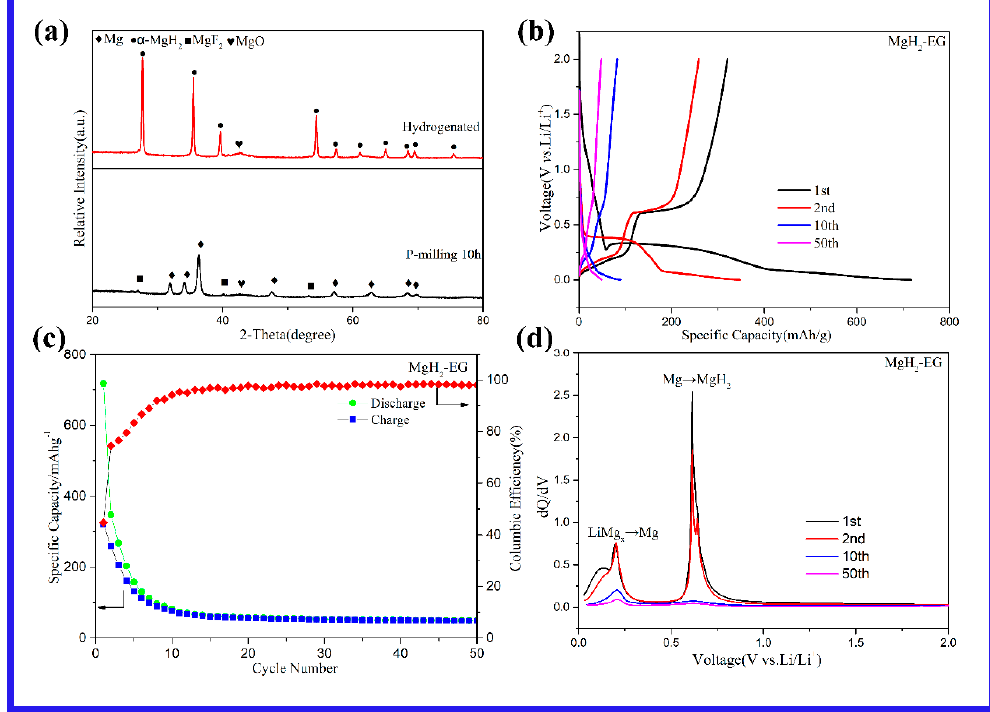
Figure 1. ( a ) XRD patterns of the as-milled and hydrogenated Mg-EG composites; ( b ) discharge/charge curves of MgH 2 –EG at a current rate of 100 mA · g − 1 ; ( c ) cycling performance of MgH 2 –EG electrode; ( d ) differential capacity plots (dQ/dV) of the MgH 2 –EG electrode at different cycles.